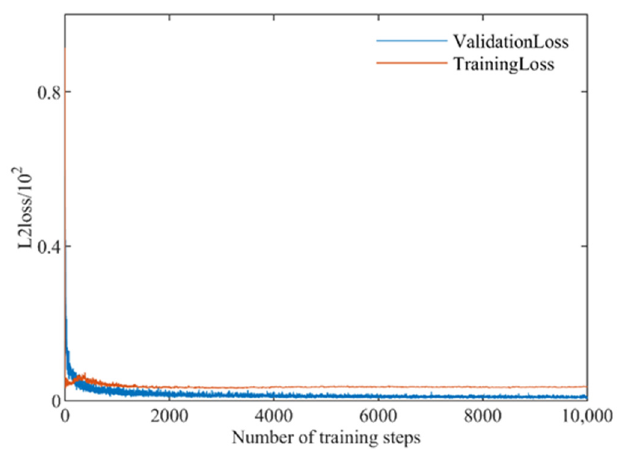
Figure 9. Loss function descent process.